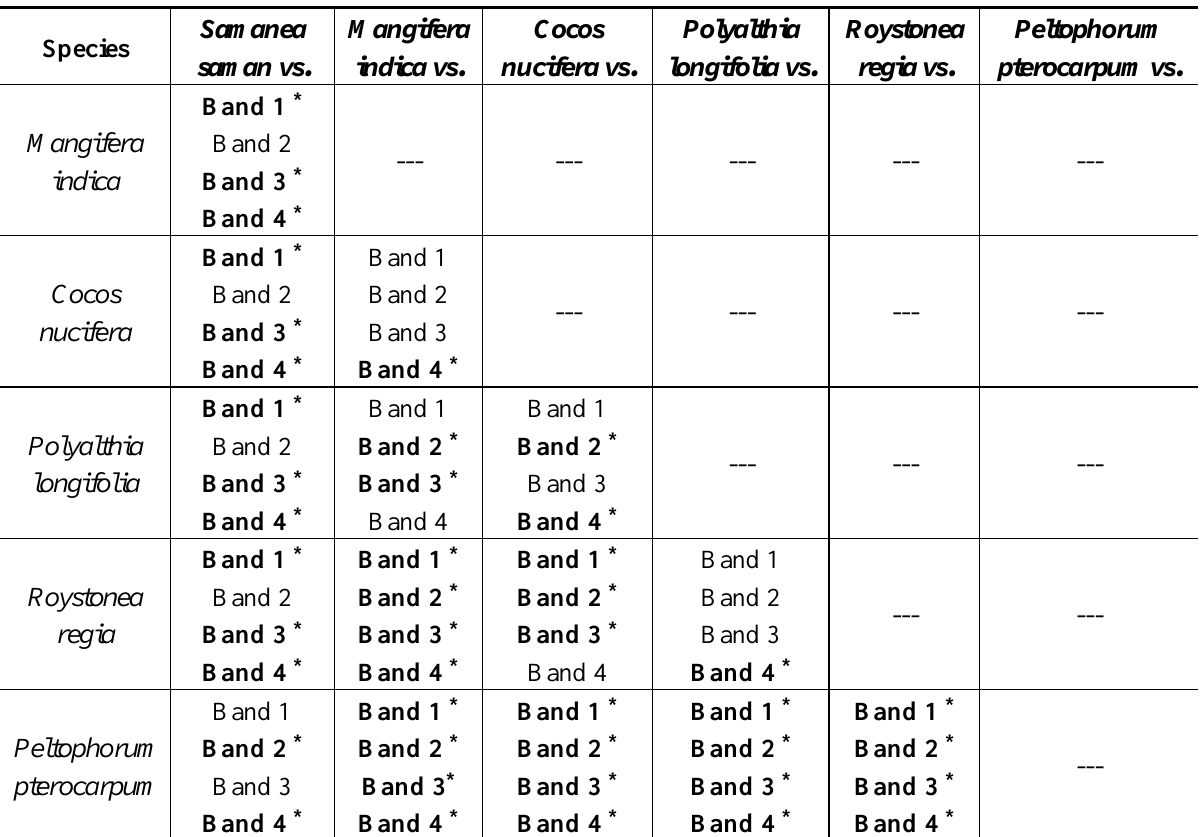
Table 2. Results of a Mann-Whitney U test to assess the statistical significance of differences in band reflectance values between pairs of tree species ( * indicates significance at p < 0.05). As this is a symmetrical matrix of pair-wise comparisons, only one part of the matrix is